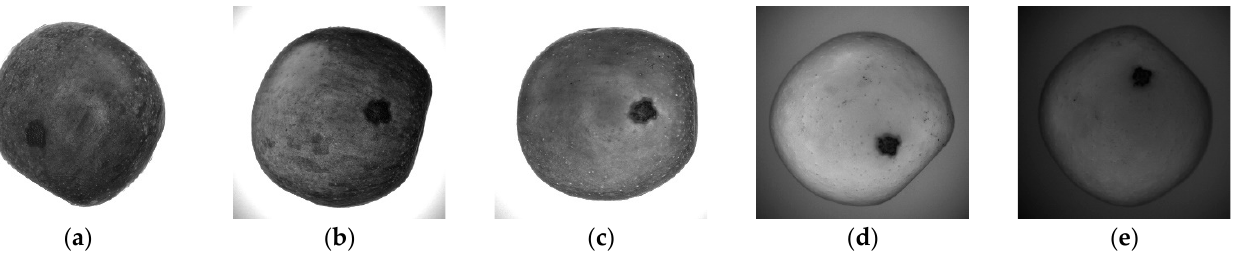
Figure 2. The apple single-band images. ( a ) 460 nm ( b ) 522 nm ( c ) 660 nm ( d ) 762 nm ( e ) 842 nm.